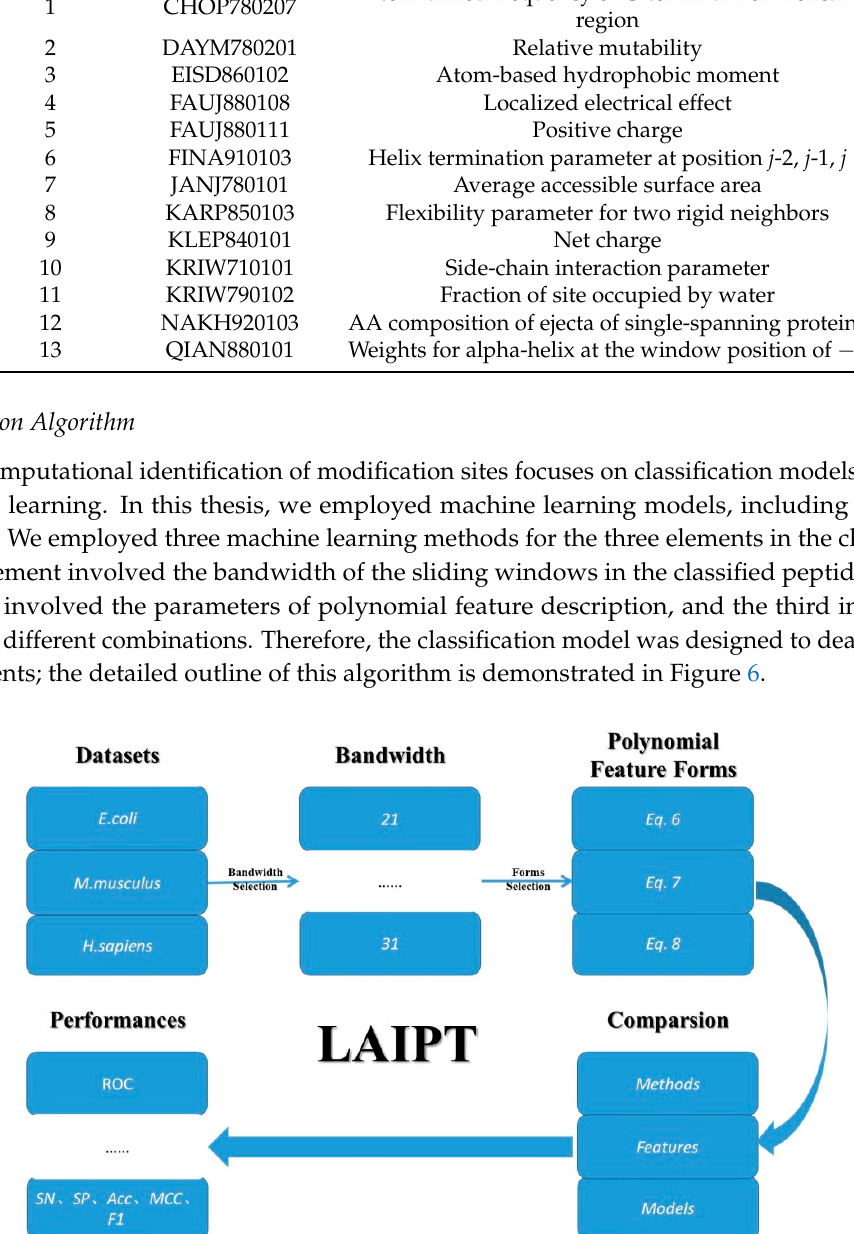
Table 10. Selected properties from the AAIndex database. AA—amino acid.